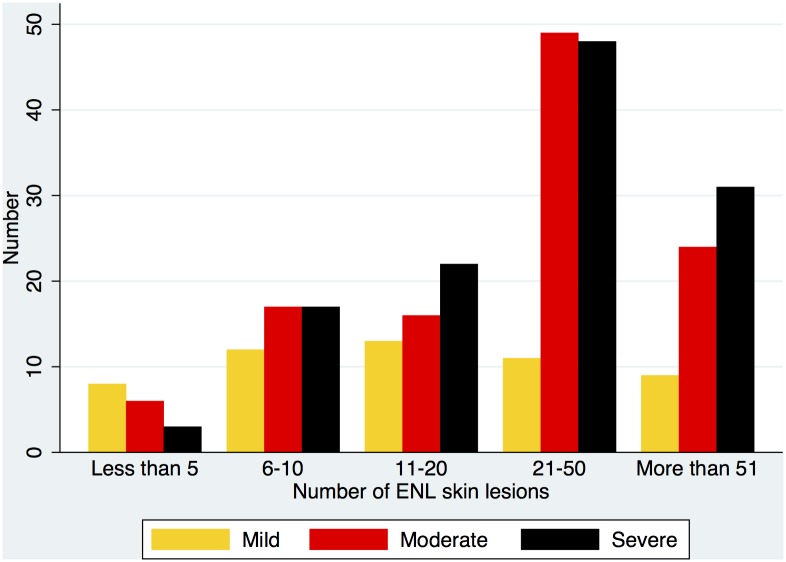
Number of skin lesions and severity of ENL.